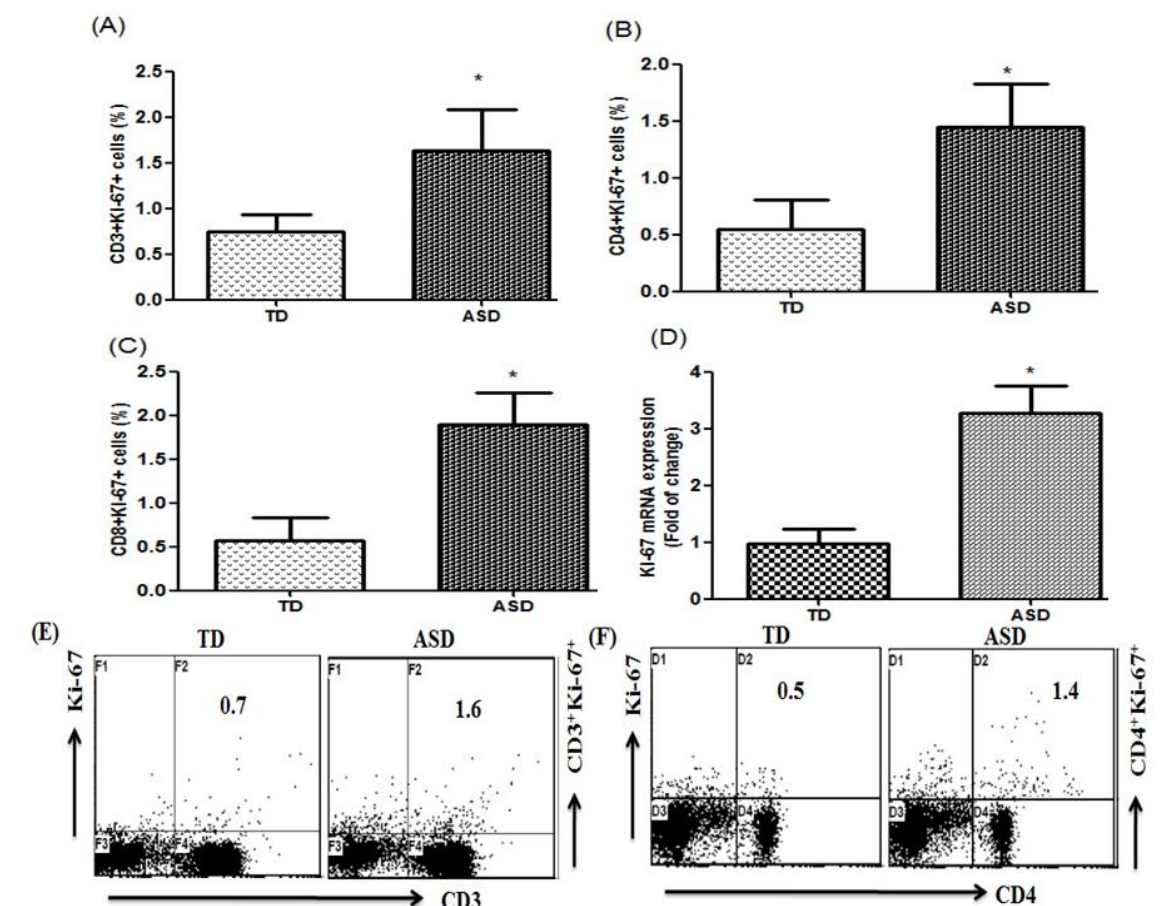
Figure 1. Ki-67 levels in CD3+, CD4+, and CD8+ T peripheral blood mononuclear cells (PBMCs). ( A – C ) flow cytometric analysis of Ki-67-producing CD3+, CD4+, and CD8+ T cells, respectively, from PBMCs in autism spectrum disorder (ASD) and typically developing (TD) controls. ( D ) The mRNA expression level of Ki-67 in PBMCs measured using quantitative RT–PCR and normalized to); glyceraldehyde-3-phosphate dehydrogenase (GAPDH). ( E , F ) Representative flow cytometry dot plots showing the percentage of Ki-67-producing CD3+ and CD4+ T cells from TD controls and children with ASD. Statistical analysis was carried out by Student’s t -test. Statistical significance was determined as * p < 0.05.